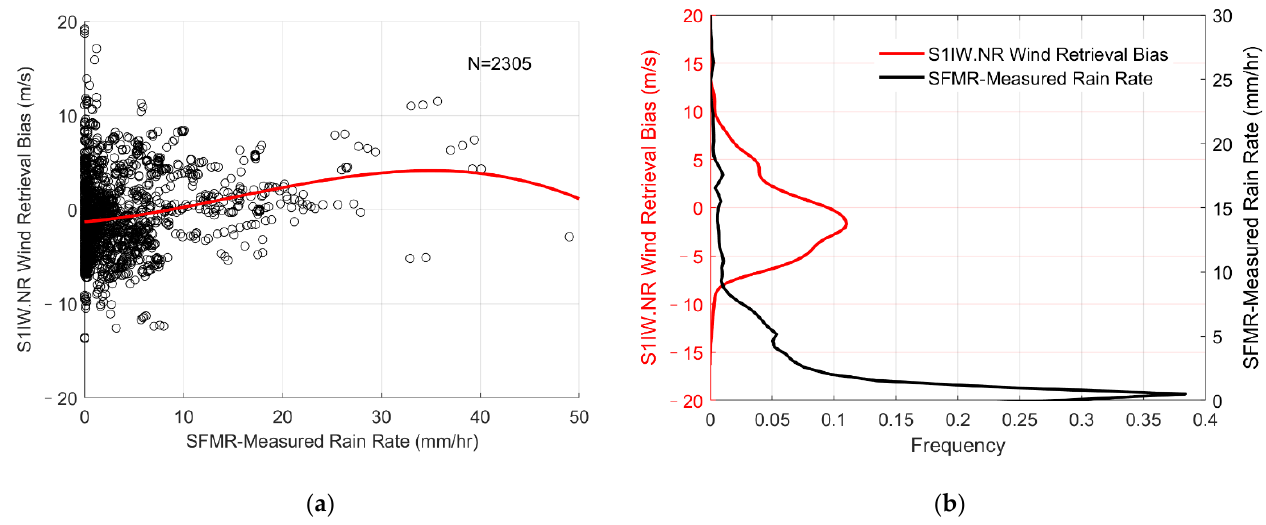
Figure 8. ( a ) Comparison and ( b ) probability density distribution of the S1IW.NR wind retrieval bias and the SFMR- measured rain rate based on Dataset 2. The red curve in ( a ) stands for the trend of bias changing with rain rate. In ( b ), the red curve is the frequency of the S1IW.NR wind speed bias, corresponding to the left Y-axis. The black curve is the frequency of the SFMR-measured rain rate, corresponding to the right Y-axis.